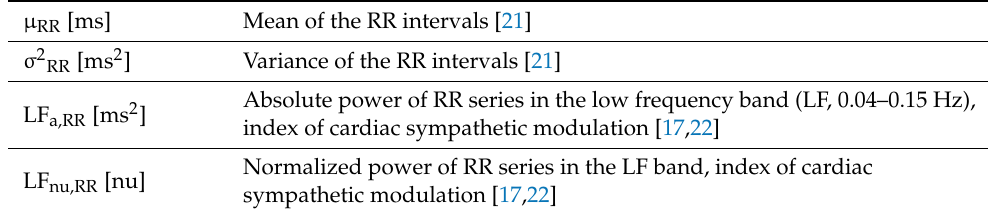
Table 1. RR and SAP variability